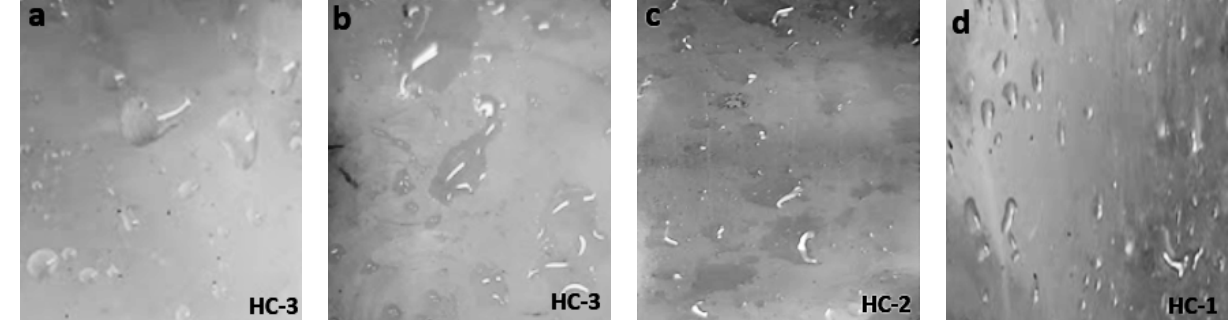
Figure 8 Images of aged (1000 h) ( a ) nSiR ( b ) SMC 15 ( c ) SNC 2.5 and ( d ) SNC 5.